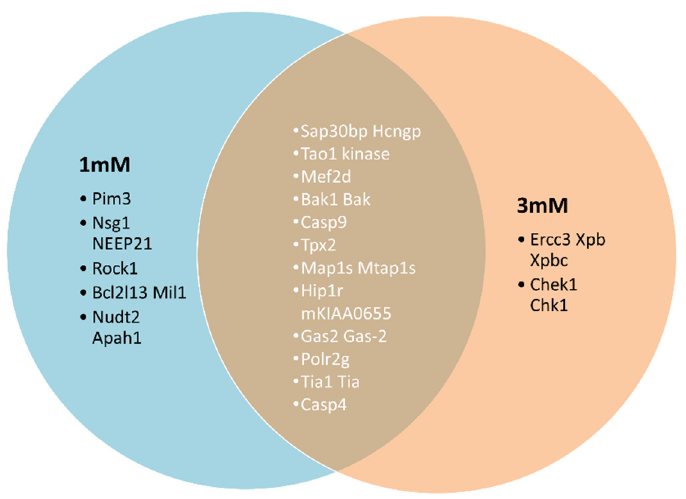
Figure 2. Venn diagram showing common overexpressed proteins following treatment of HEI-OC1 to 1 mM and 3 mM concentrations of gentamicin.